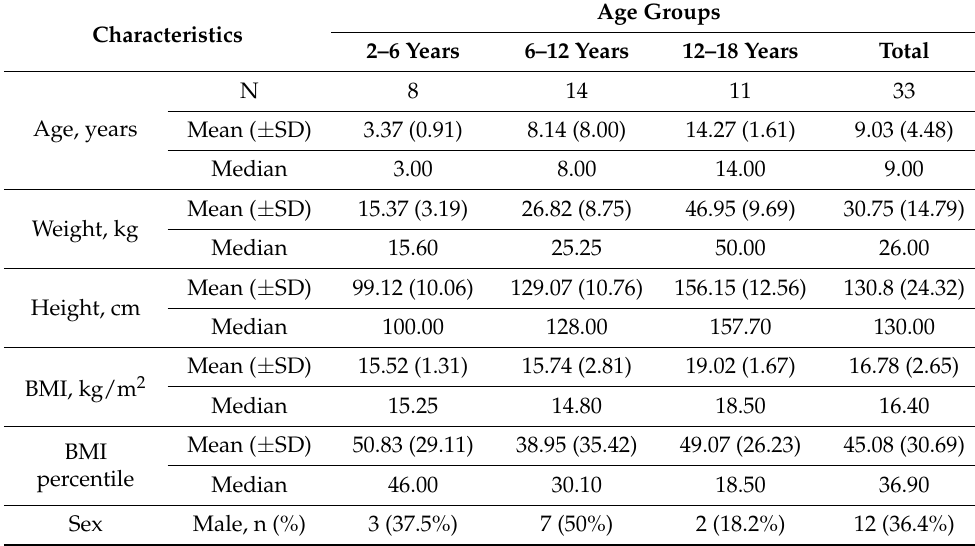
Table 1. The basic characteristics of the study population.